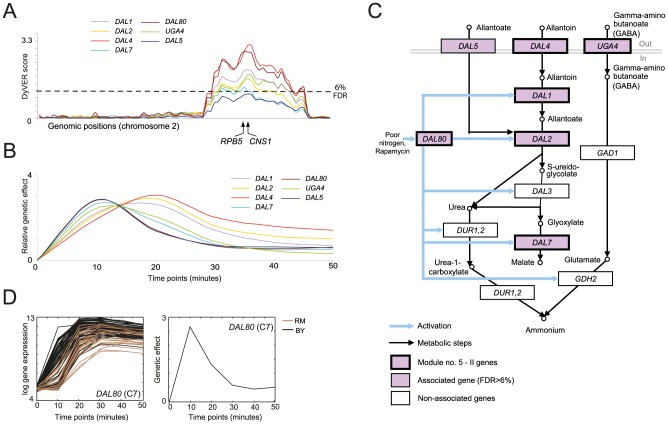
A genetic variant acting on the timing of response of the poor nitrogen-source degradation pathway (module no. 5-II).(A) The genomic interval underlying module no. 5-II residing in Chr2: 533–562 kb. Shown are DyVER scores (y-axis) across the genomic positions in chromosome 2 (x-axis) for seven associated genes (color coded; the module includes only those six genes that cross the FDR 6% threshold). Positions of two potential causal variants, RPB5 and CNS1, are marked below. (B) Genetic effects, relative to non-stimulated genetic effects (y-axis, log-scaled) for different associated genes from A (color coded) at six time points (x-axis). The plot depicts the short impulse of high genetic effect in all associated genes. (C) Module genes, in the context of the poor nitrogen-source degradation pathway. Enzymes are shown as color-coded rectangles (bold-pink/module genes, pink/associated genes, white/non-associated genes). The pathways show the uptake of poor nitrogen sources (allantoate, allantoin, and GABA) and their degradation into ammonium. (D) A representative gene. Expression profiles (left) and genetic effects (right, y-axis) of DAL80, a gene in module no 5-II, during response to rapamycin (x-axis). Shown as in Fig. 4B but using a marker near the RPB5 gene (marked in A).